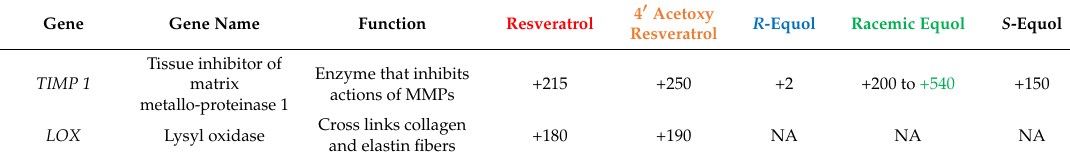
Table 4. Human skin TIMP and LOX gene expression among resveratrol, 4 (cid:48) acetoxy resveratrol, R -equol, racemic equol or S -equol as the percentage of the increase (+) compared to